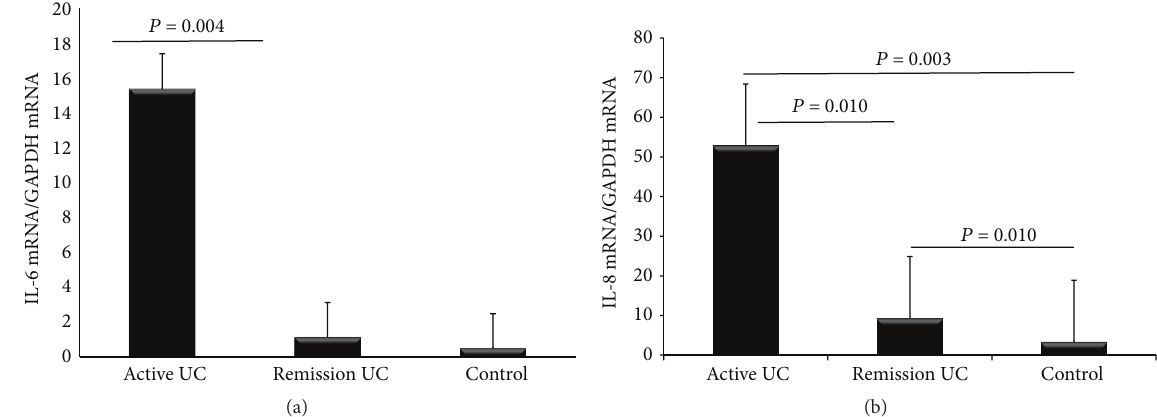
Figure 4: IL-6 and IL-8 mRNA levels in colonic mucosa from patients with ulcerative colitis and controls. RT-qPCR was performed to assess mRNA levels in colonic mucosa biopsies from UC patients, bars show means with standard error of the mean of IL-6 and IL-8 transcript levels with GAPDH, RPLP0, and ACTB as housekeeping gene determined by 2 ΔΔ Ct, and differences among groups were assessed by Kruskal-Wallis test.